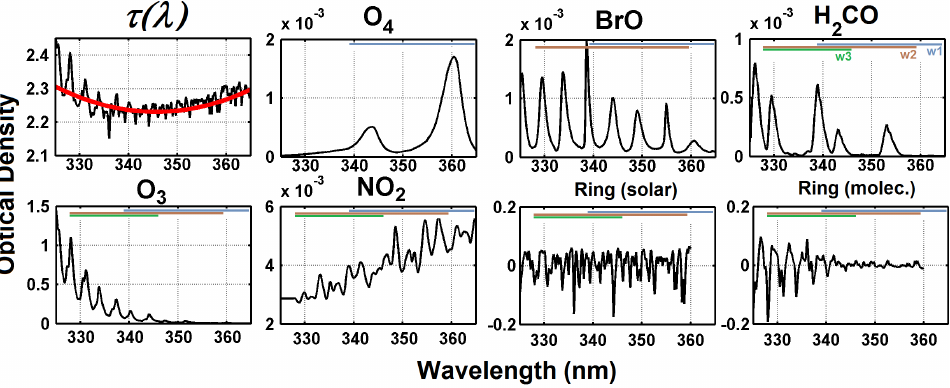
Figure 1. Typical log ratio of the measured Earth reflectance and fitted low-order polynomial (black and red lines in the first panel), and optical densities of O 2 –O 2 (O 4 ) , BrO, H 2 CO, O 3 , NO 2 and the Ring effect (solar lines and molecular) in the near UV. The slant columns have been taken as 0.4 × 10 42 molec 2 cm − 5 for O 4 , 10 14 moleccm − 2 for BrO, 10 16 moleccm − 2 for H 2 CO, 10 20 moleccm − 2 for O 3 and 1 × 10 16 moleccm − 2 for NO 2 . The different wavelength intervals used in the retrieval are indicated as w1, w2 and